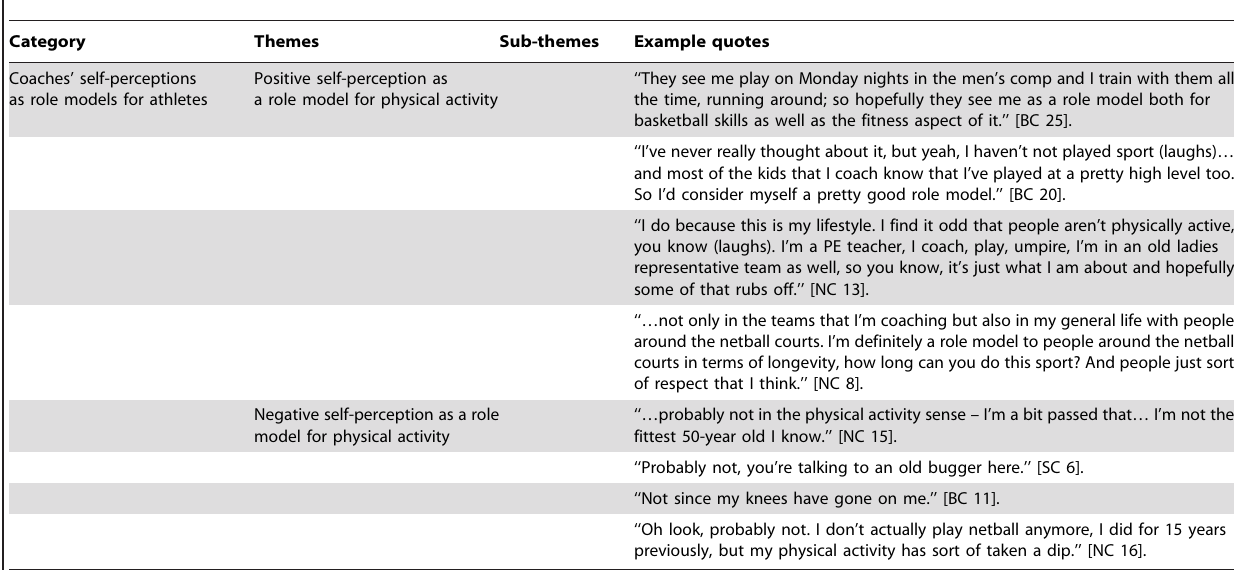
Table 4. Coaches’ perceptions of themselves as role models for physical activity: summary of categories, themes, sub-themes, and example